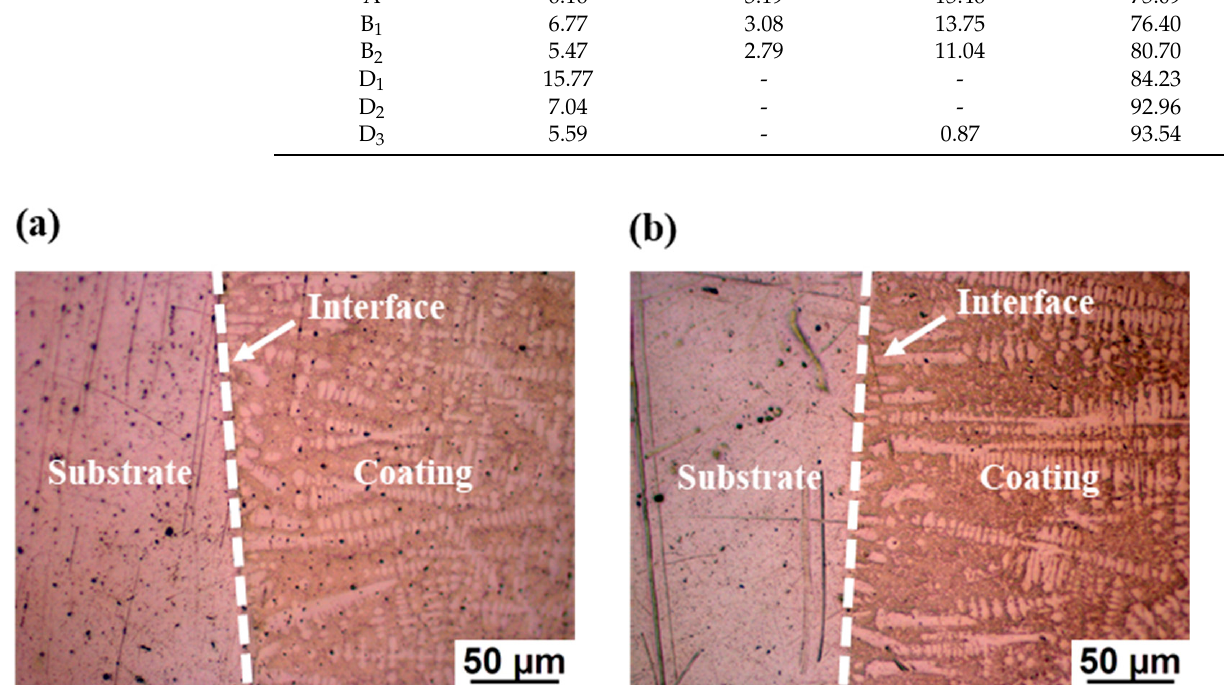
Figure 4. XRD patterns of the coatings. Table 3. Chemical composition of phases in Figures 5 and 6. Element Composition (at.%) Region